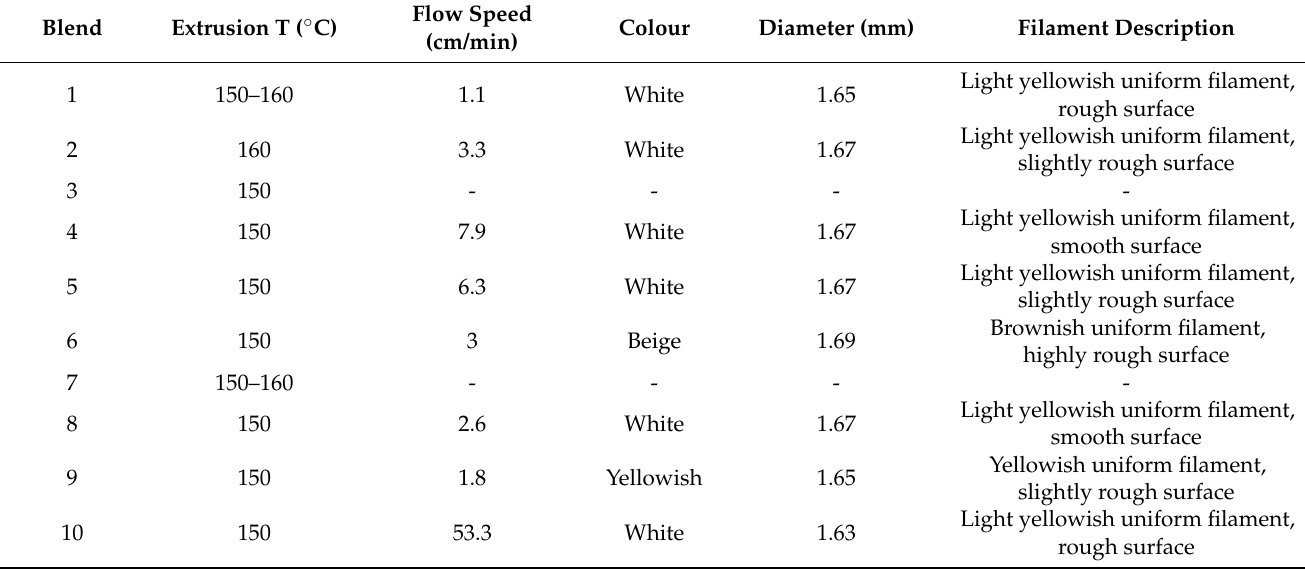
Table 2. Extrusion process parameters and filament properties of preliminary